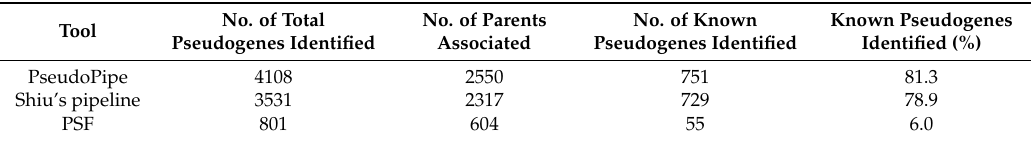
Figure 4. Comparisons of three bioinformatics tools for pseudogene prediction using the A. thaliana genome with its 924 known pseudogenes. ( A ) Identified known pseudogenes; ( B ) all identified pseudogenes. Table 3. Comparison of thee bioinformatics tools employed for pseudogene prediction using the Arabidopsis thaliana genome sequence with its 924 known pseudogenes.